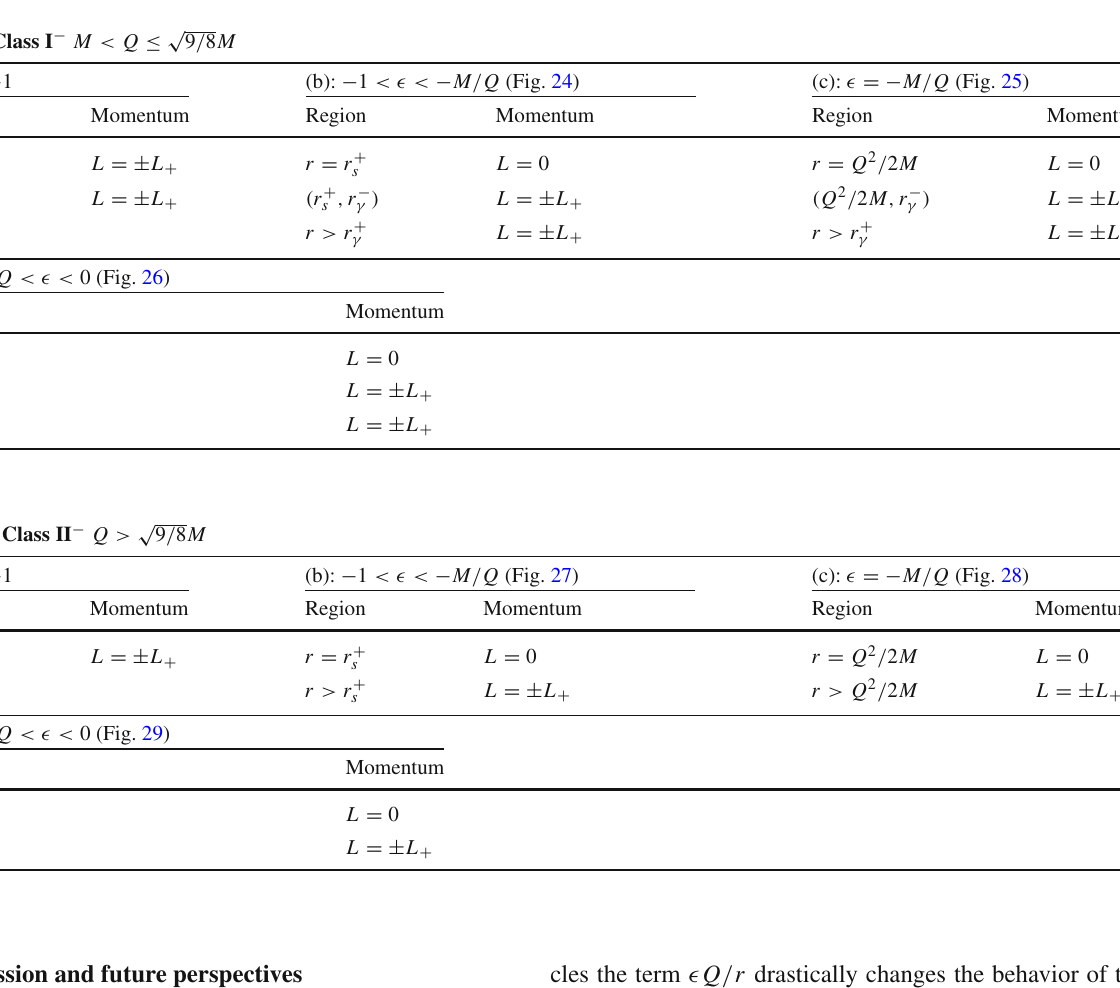
Table 9 Class I − M < Q ≤